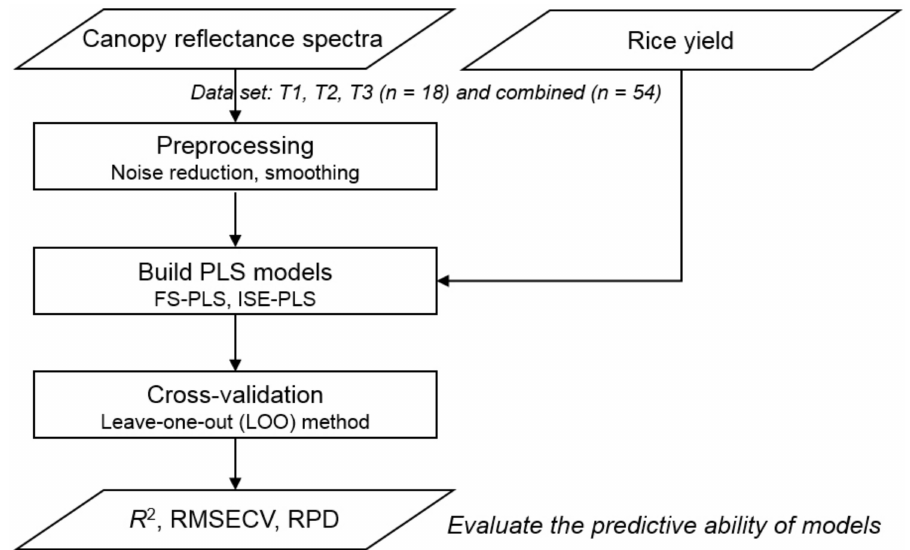
Figure 4. Flowchart depicting a general overview of the